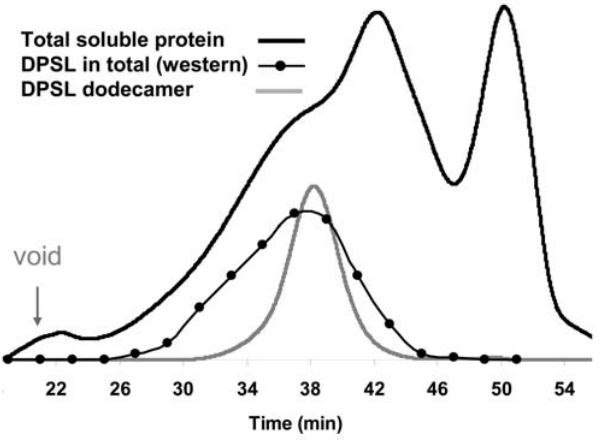
Figure 6. Size exclusion chromatography of DPSL. SEC data shows that a significant portion of DPSL from H 2 O 2 stressed cells is part of a larger molecular complex. Total soluble protein, 105 min. after H 2 O 2 exposure (black line) and purified recombinant DPSL separated under identical conditions (gray line) were detected by monitoring at 280 nm. Western blot analysis of the total soluble protein fractions using anti-DPSL antibody shows that in vivo part of the DPSL elutes earlier (27–34 min) in comparison to the purified wild type DPSL ( , 38 min) indicating that it is part of a larger molecular